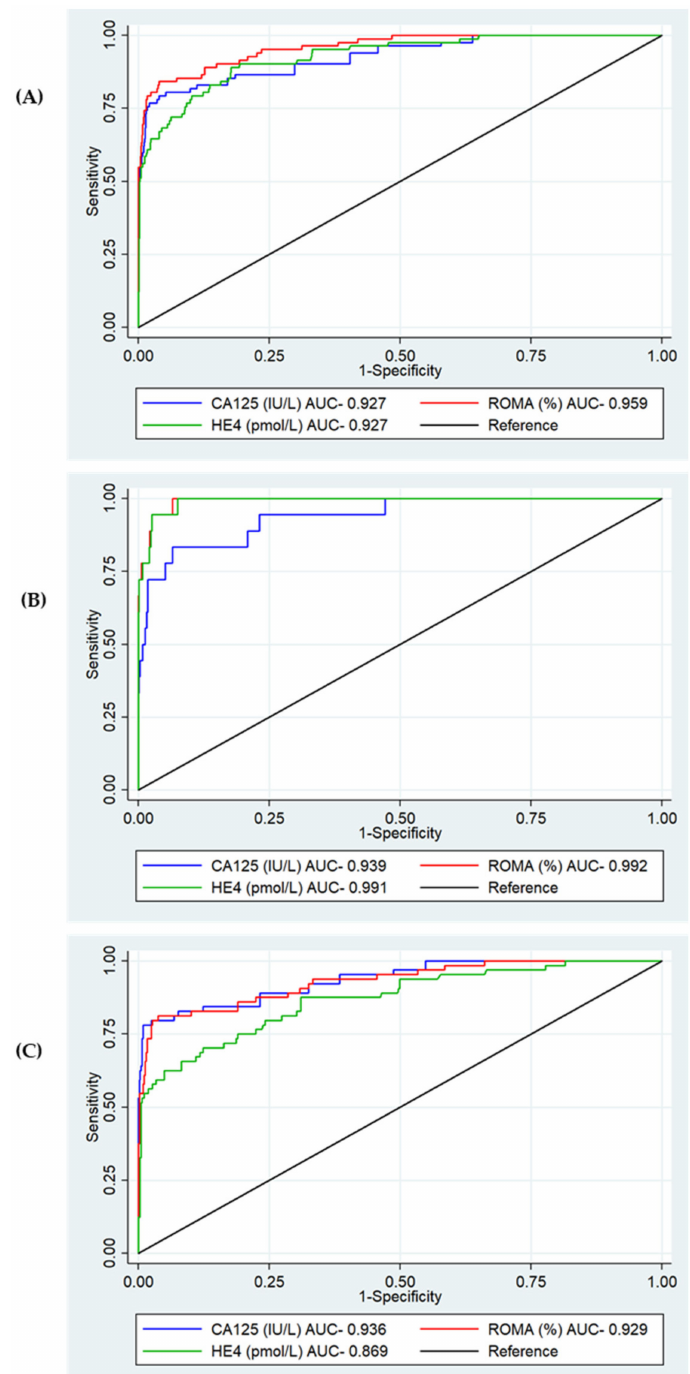
Figure 3. ROC analysis for serum CA125, HE4 and ROMA for the detection of epithelial ovarian cancer. ( A ) Overall. CA125 AUC 0.927 (95%CI 0.892–0.961), HE4 AUC 0.927 (95%CI 0.897–0.957), ROMA AUC 0.959 (95%CI 0.937–0.980) p = <0.001. ( B ) Under 50. CA125 AUC 0.939 (95%CI 0.881– 0.996), HE4 AUC 0.991 (95%CI 0.982–1.000), p = 0.06. ( C ) Over 50. CA125 AUC 0.936 (95%CI 0.901–0.972), HE4 AUC 0.869 (95%CI 0.817–0.921), p <